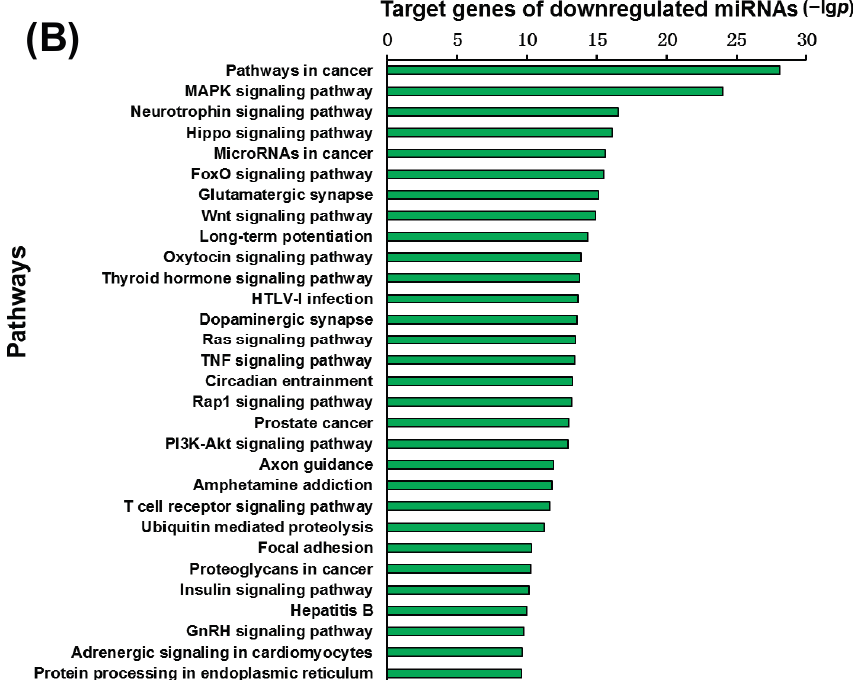
Figure 6. Target genes of the up-regulated miRNAs ( A ) and down-regulated miRNAs ( B ) annotated significant pathways. The vertical and horizontal axes are the pathway terms and the − lg p of pathways, respectively. lg p is the logarithm of p value and p < 0.05 is considered significant.